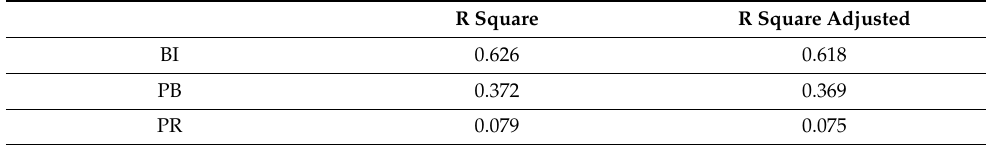
Table 7. Coefficient of determination (R 2 ) values.